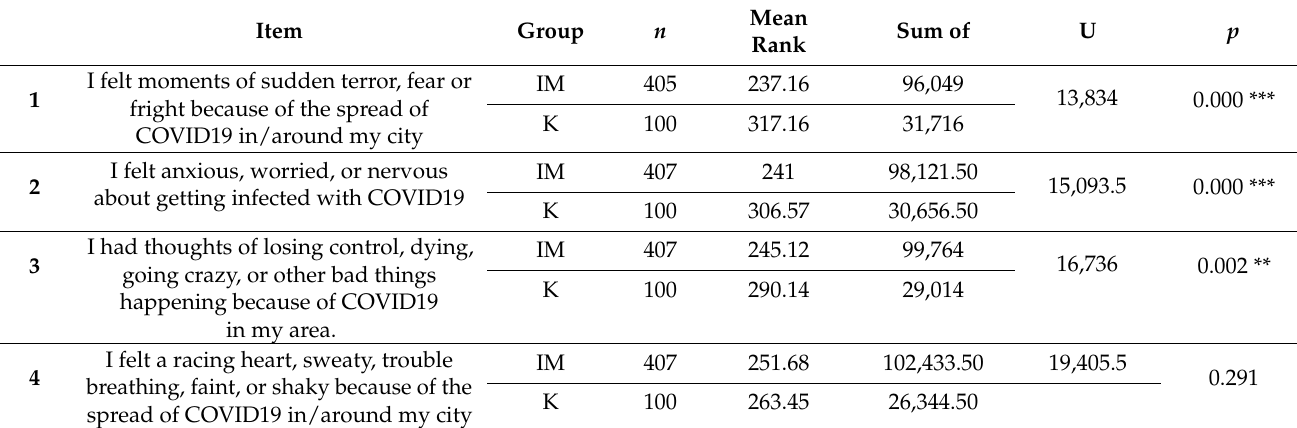
Table 3. Mann–Whitney U-Test on panic severity scale.